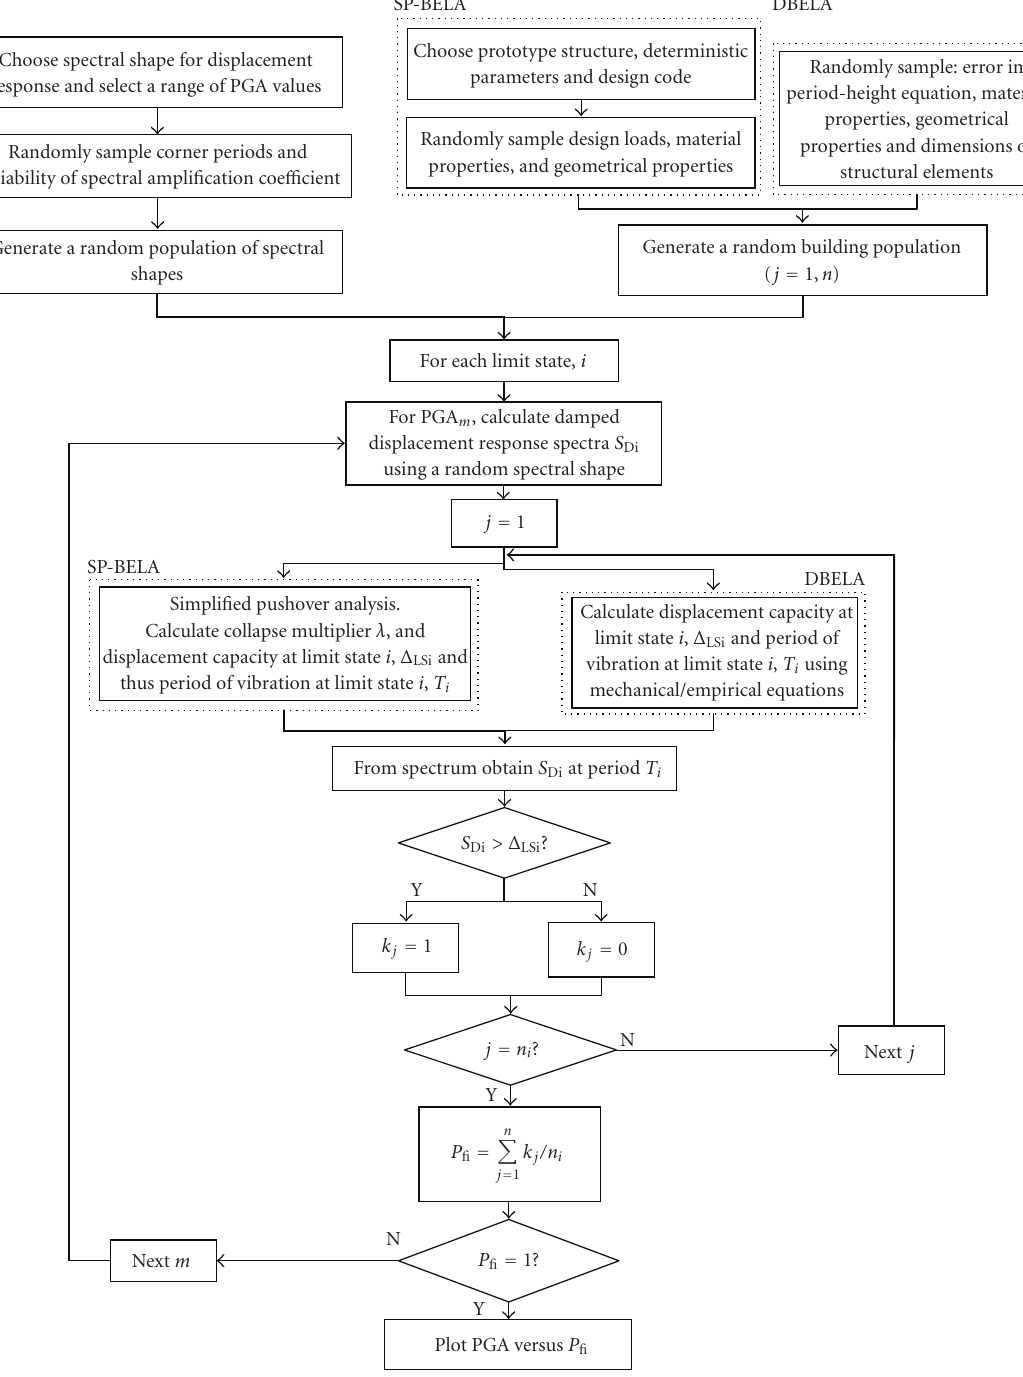
Figure 15: Flowchart of the DBELA and SP-BELA methodologies for the derivation of vulnerability curves for RC buildings. with the most vulnerable direction of the building being considered in